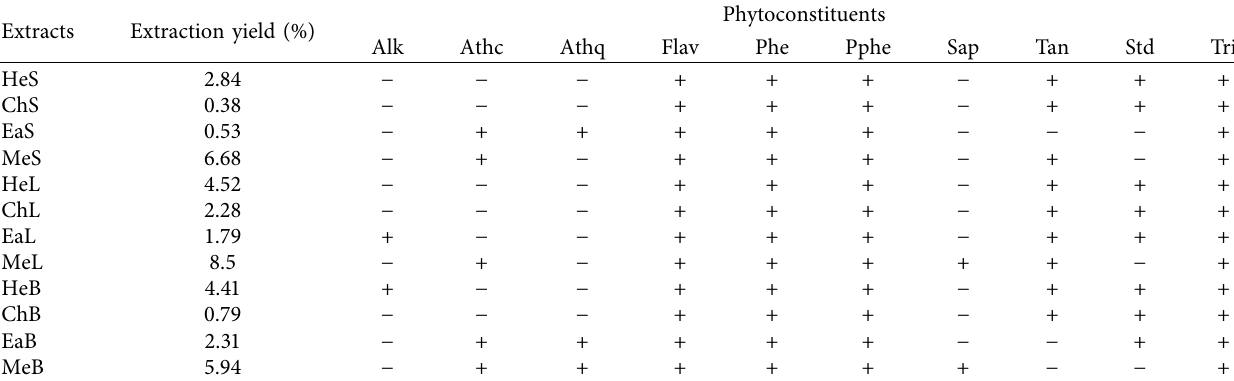
Table 1: Phytochemical screening of leaf, seed, and bark extracts of E. japonica . Extracts Extraction yield (%)